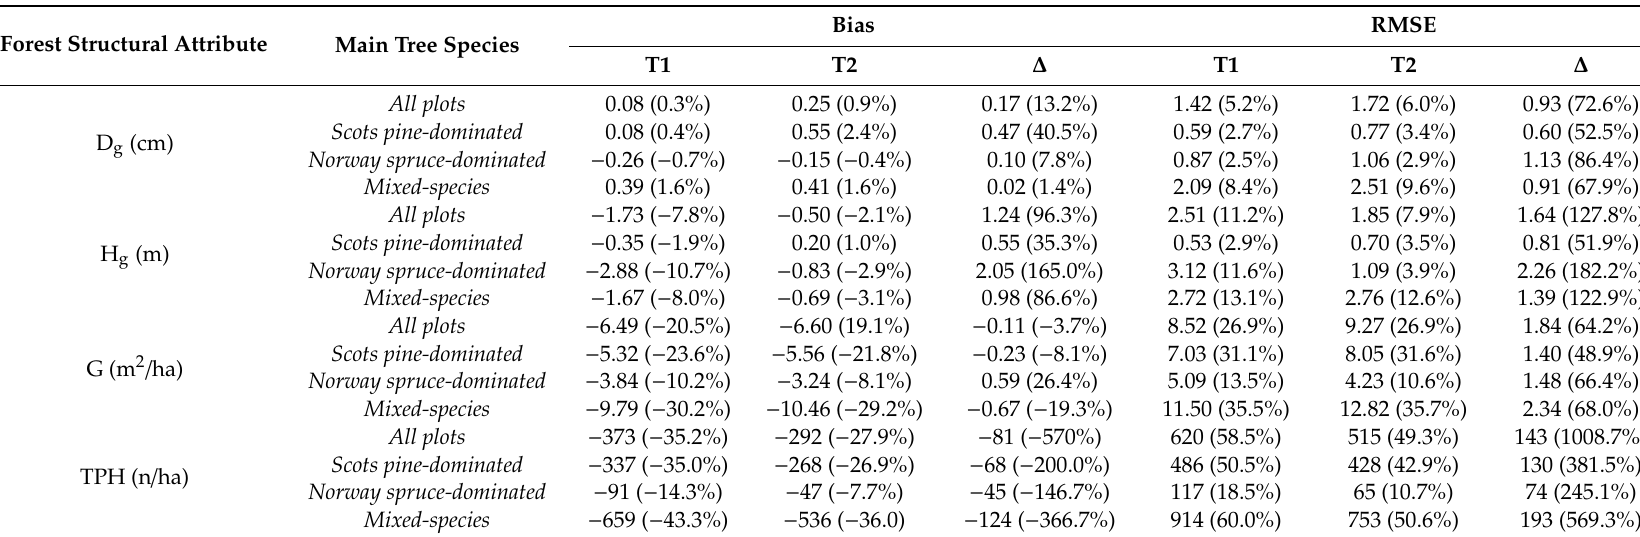
Table 6. Bias and root-mean-square-error (RMSE) of TLS-derived estimates for forest structural attributes, namely basal area-weighted mean diameter (D g ) and -height (H g ), mean basal area (G) and number of trees per hectare (TPH) in 2014 (T1) and 2019 (T2) as well as their change ( ∆ ). Negative bias denotes underestimation. Forest Structural